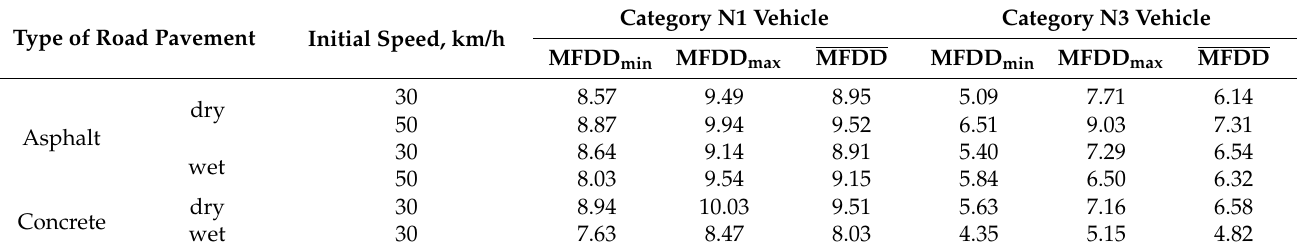
Table 7. List of mean fully developed braking deceleration (MFDD) values.